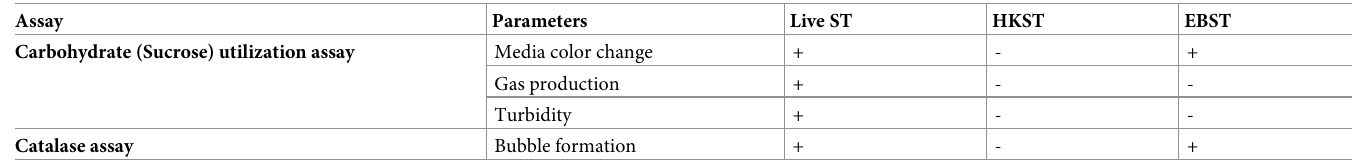
Table 2. eBeam-inactivated S . Typhimurium (EBST) remains metabolically active and tests positive for standard biochemical and enzymatic assays. Assay Parameters Live ST HKST EBST Carbohydrate (Sucrose) utilization assay Media color change